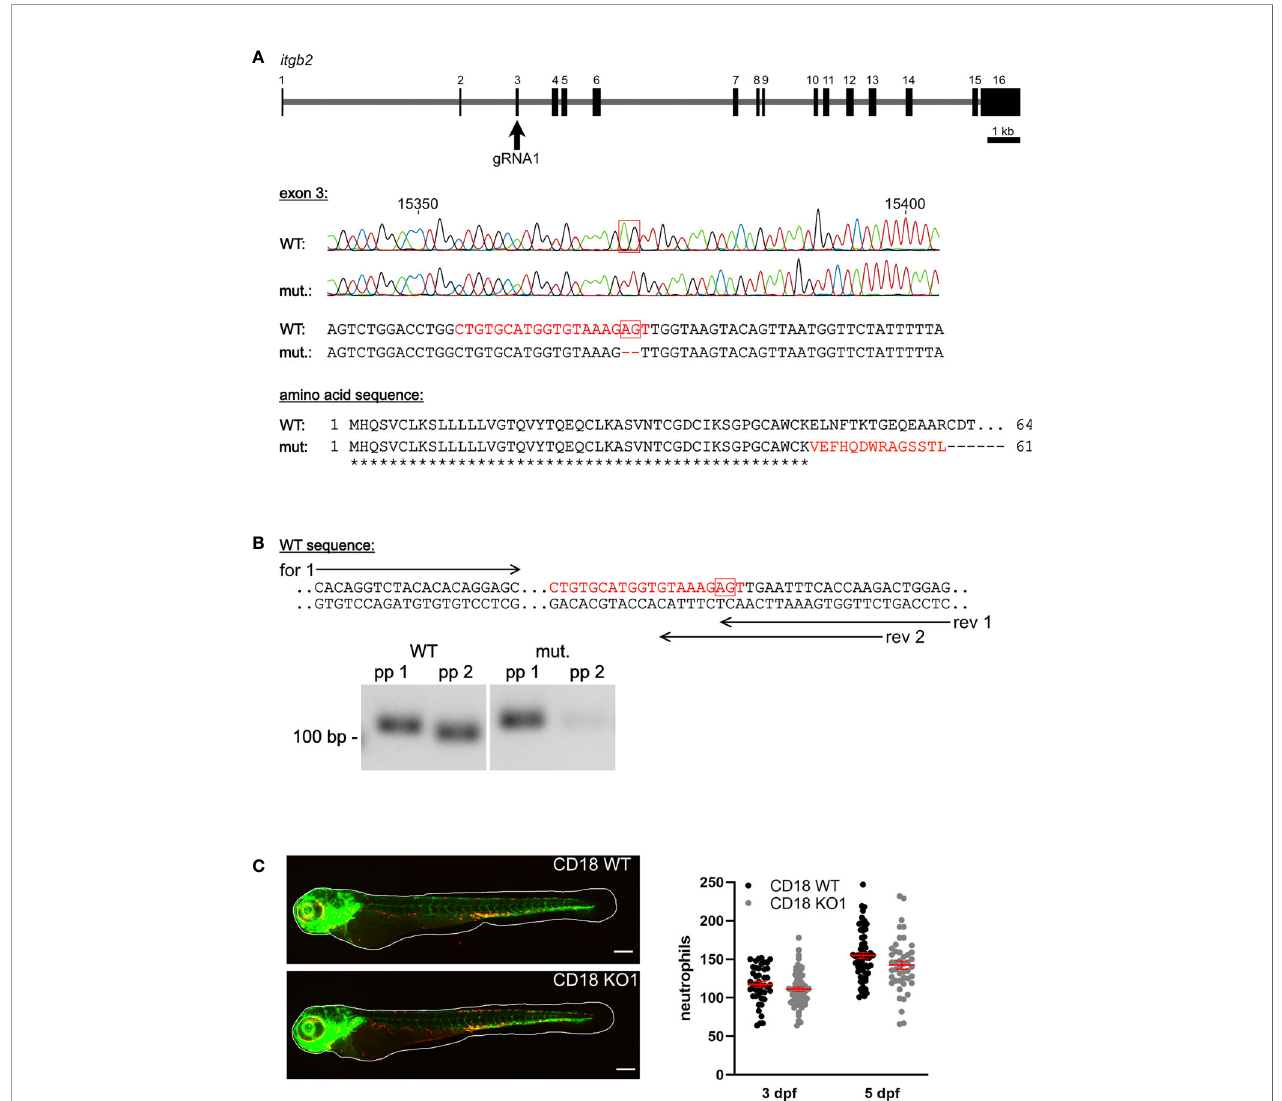
FIGURE 1 | Generation of a CD18 KO zebra fi sh and analysis of neutrophil count. (A) Upper panel: Schematic of itgb2 gene and target exon 3 of the gRNA1. Middle panel: Sequencing traces and partial genomic sequence of WT and CD18 mutant (mut.). Numbers indicate position within the gene. Red boxes show nucleotides deleted in the mutant. Highlighted is the target sequence of the gRNA in red. Lower panel: Predicted amino acid sequence of mutants aligned to WT sequence of the fi rst 64 amino acids. Identical (*) and altered (red) amino acids are indicated. (B) Upper panel: Location of primer pairs for PCR analysis of WT and CD18 mutant mRNA expression analysis. Reverse (rev) primer 1 binds to WT and CD18 mutant sequence, reverse primer 2 only binds the WT sequence. Forward (for) primer 1 was combined with both reverse primers. Lower panel: Representative image of agarose gel electrophoresis of PCR products of WT and CD18 mutant cDNA with primer pairs (pp) 1 (forward primer 1, reverse primer 1) and 2 (forward primer 1, reverse primer 2), respectively, from zebra fi sh larvae at 5 dpf. Expected band sizes are 117 bp for pp 1 and 110 bp for pp 2. (C) Left: Exemplary maximum intensity projections of CD18 WT and CD18 KO1 zebra fi sh larvae at 3 dpf. Endothelial cells are shown in green, neutrophils in red. Scale bars represent 200 µm. Right: Total neutrophil counts in CD18 WT and CD18 KO1 zebra fi sh larvae at 3 dpf and 5 dpf. Mean ± sem of ≥ 44 individual larvae of ≥ 3 independent experiments. Unpaired